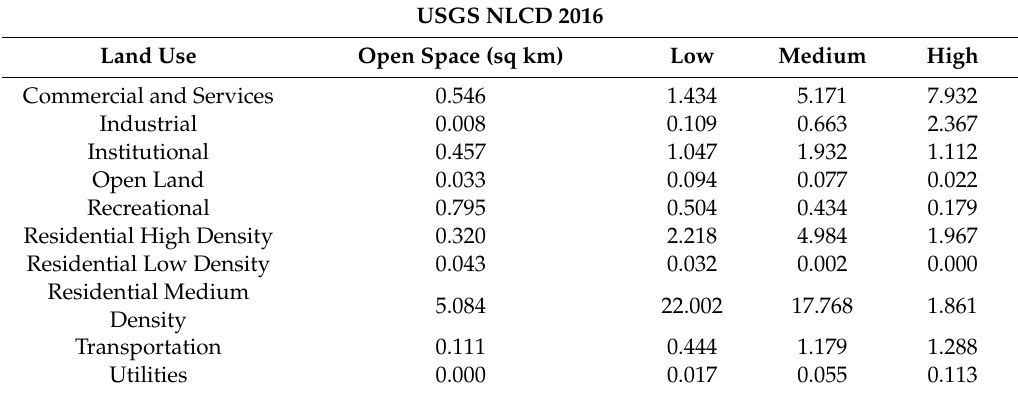
Table 9. Area statistics of 2016 urban intensity classifications, referencing FDEP